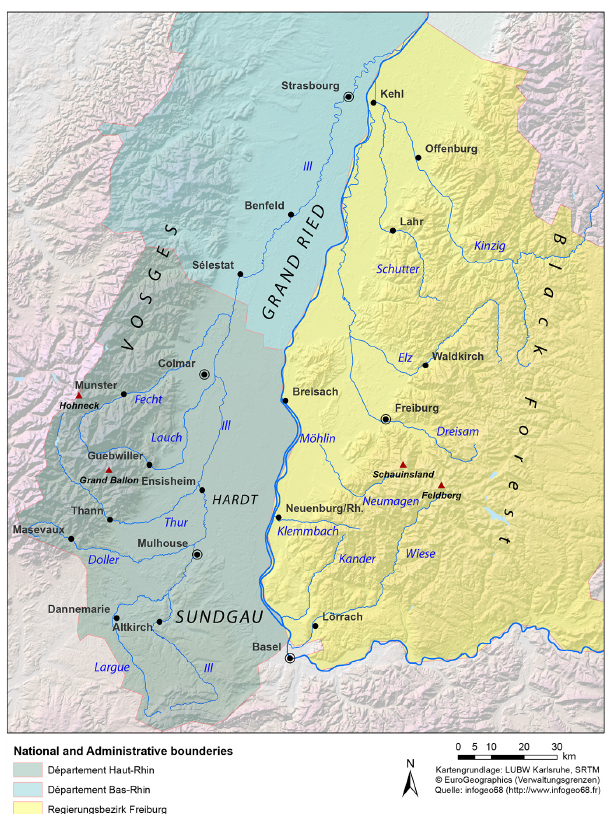
Figure 2. Damage map of the flood in September 1881 (Type